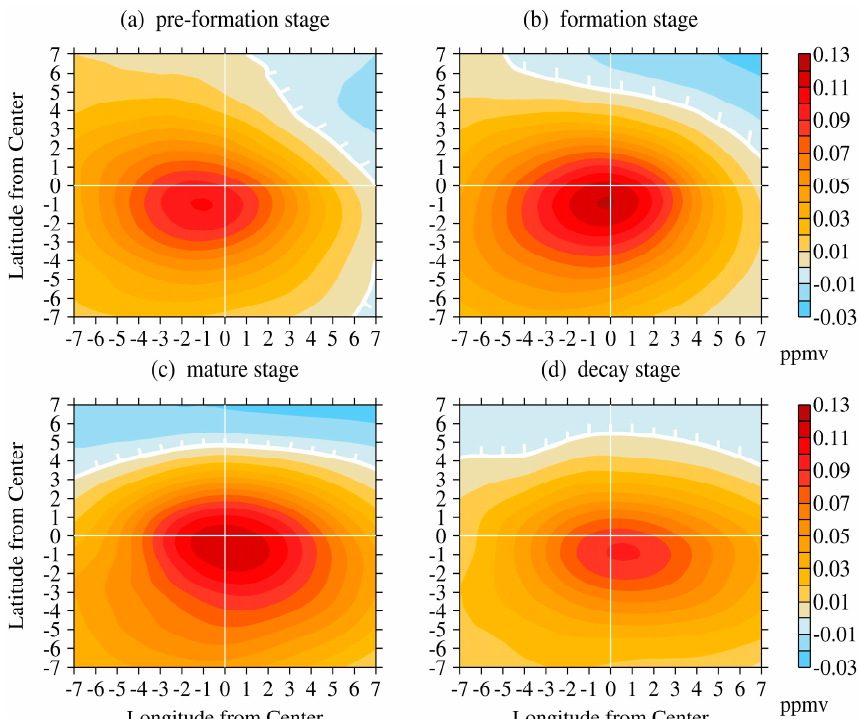
Figure 5. The horizontal distribution of ozone anomalies (unit: ppmv) at 300 hPa in the research region at four stages: the pre-formation stage ( a ), formation stage ( b ), mature stage ( c ), and decay stage ( d ). The regions “downhill” of the white thick contour did not meet the 95% confidence level following a t- test.